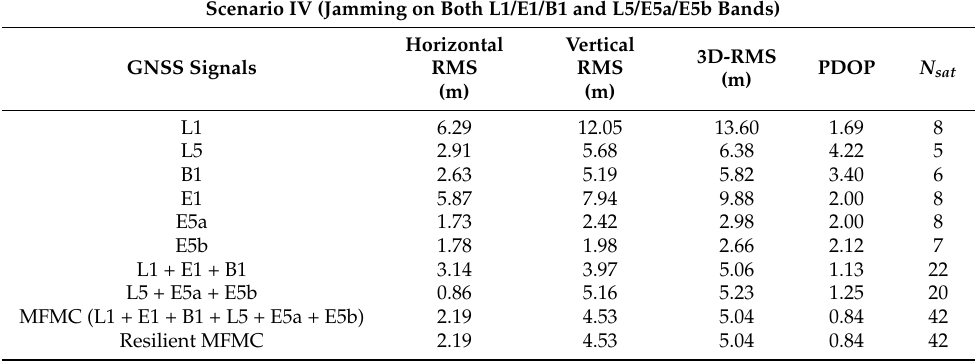
Table 7. Positioning accuracy of Scenario IV with different signal